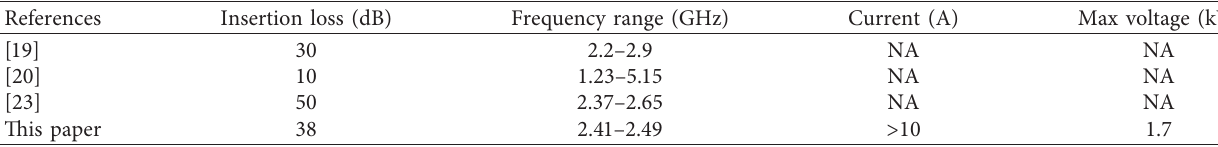
Table 3: Comparison with previously reported filters.